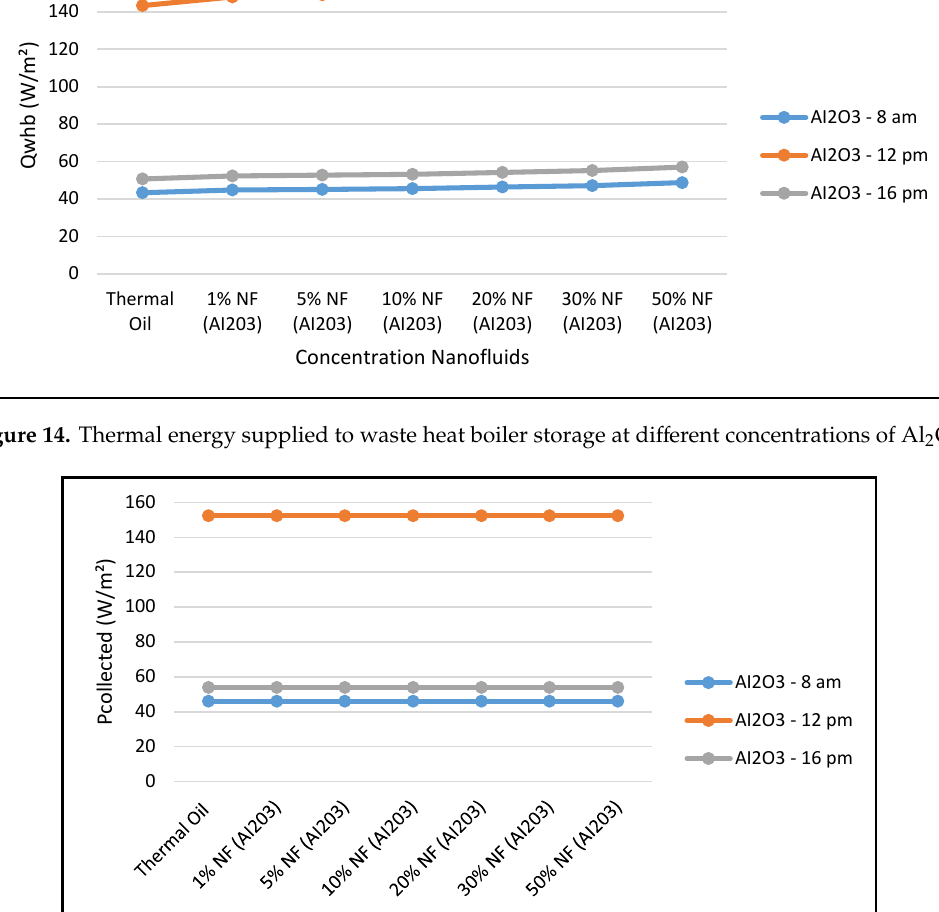
Figure 15. Power collected at CSP at different concentrations of Al 2 O 3 .